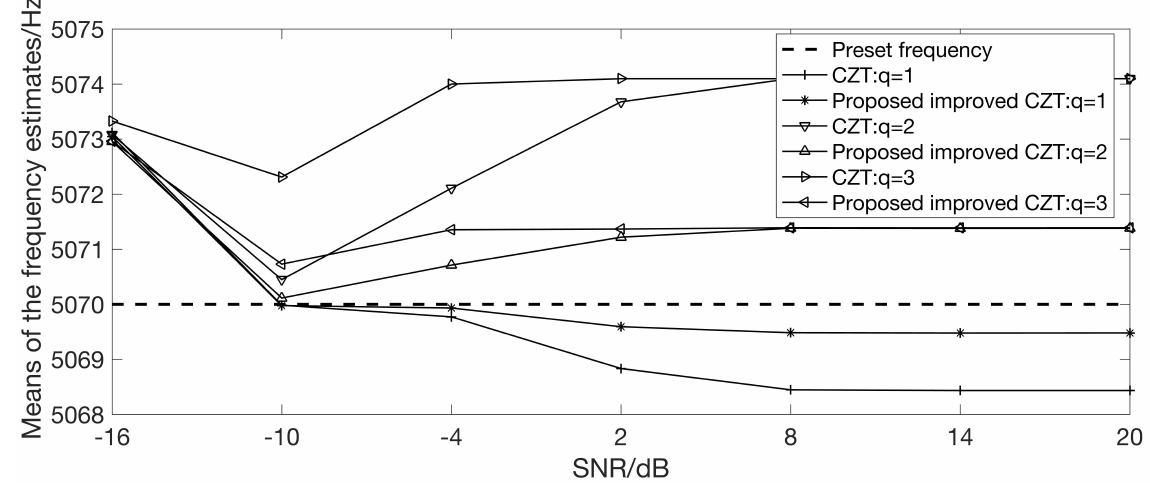
Figure 1. The frequency estimates of the proposed method versus various values of q